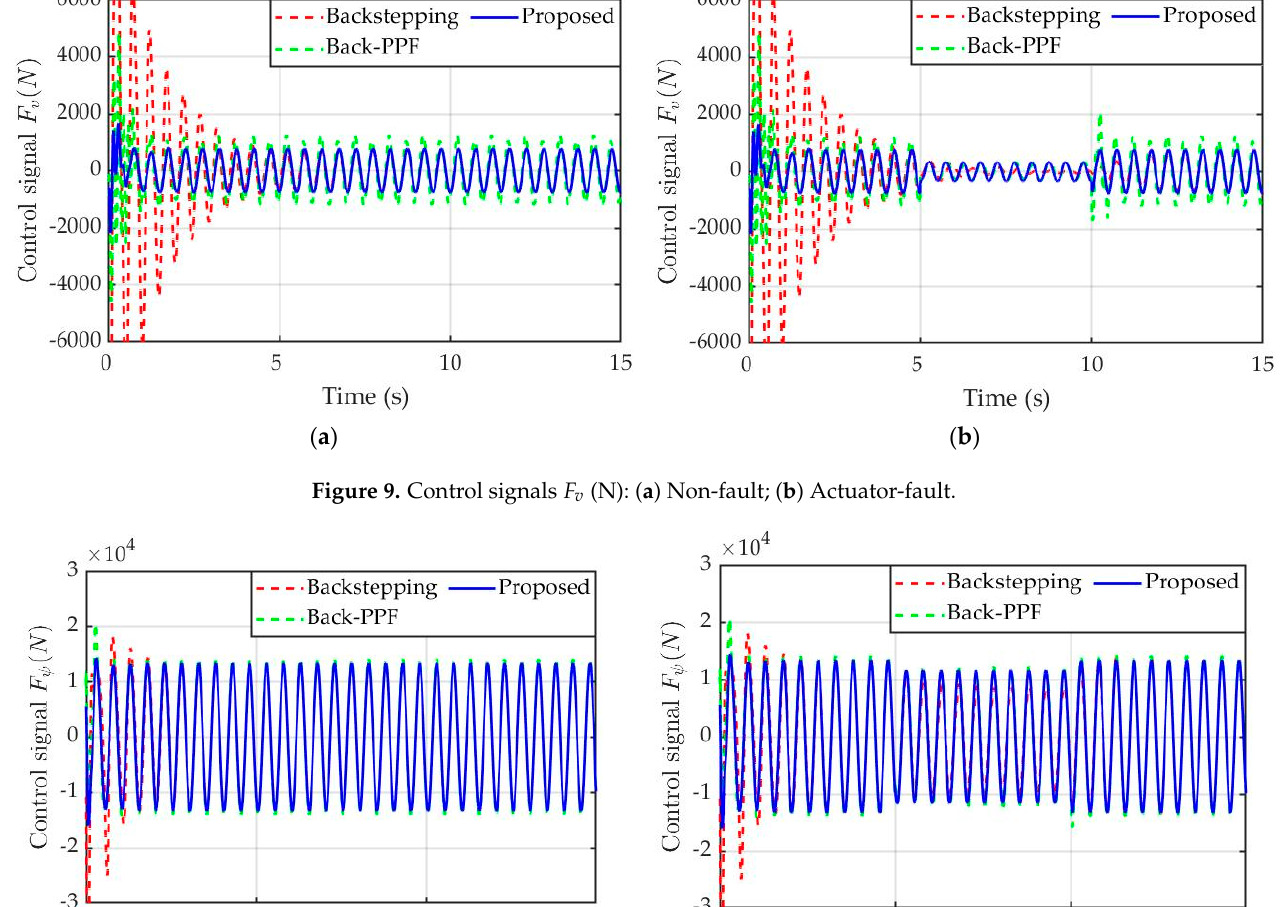
Figure 8. Relative tire force responses: ( a ) Non-fault; ( b ) Actuator-fault.